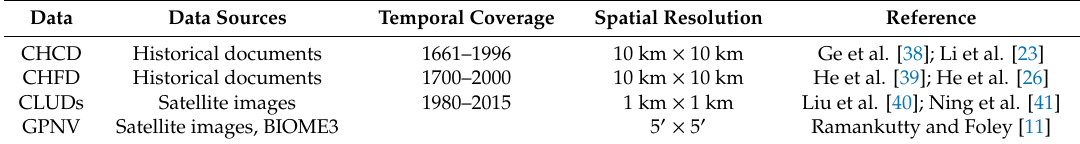
Table 1. Details of historical cropland (CHCD) and forest (CHFD) data for China, remotely sensed data (China’s land use / cover datasets, CLUDs), and global potential natural vegetation (GPNV)